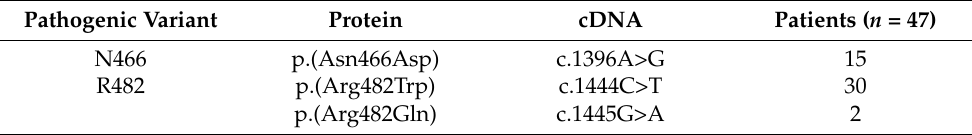
Table 1. Pathogenic variants detected in exon 8 of the LMNA gene in the study population. Pathogenic